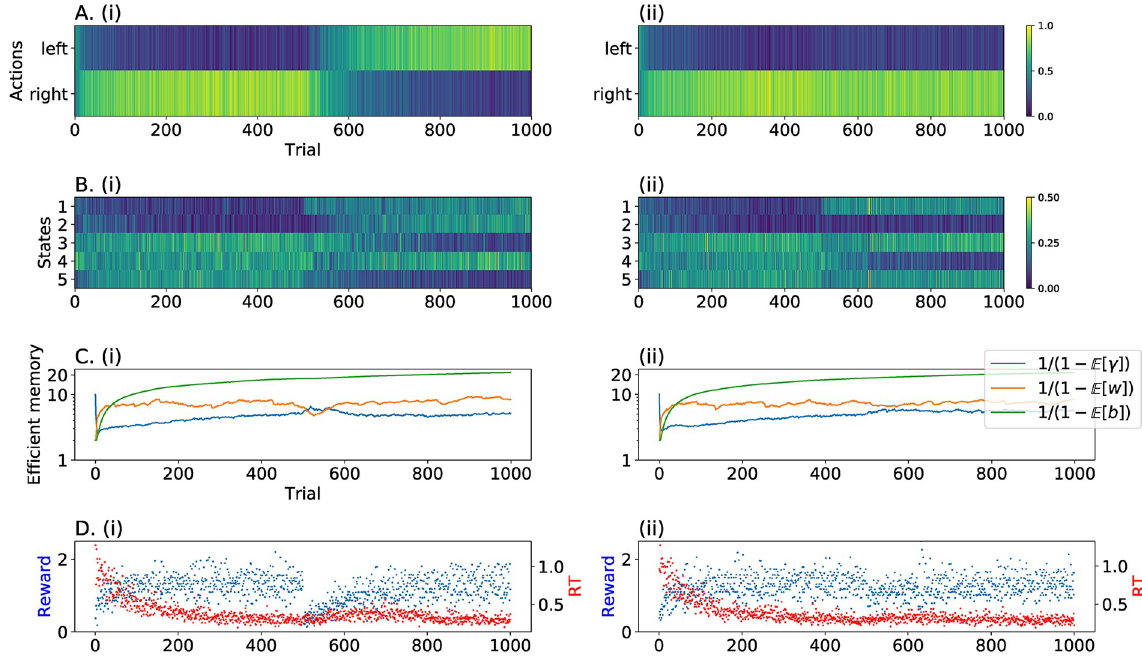
Fig 12. Behavioural results in the first (left of Fig 11) and second experiments (right of Fig 11). A . and B . Heat plot of the probability of visiting each state and selecting each action for the 64 agents simulated. (i) Agents progressively learned the first optimal actions (left action in state 3-4-5) during the first half of the experiment, then adapted their behaviour to the new contingency (right action in states 1-4-2). (ii) Similarly, in the second experiment, agents adapted their behaviour according to the new contingency (left action in 1-3-5). C . Efficient memory on the first and second level, and foreseeing capacity. Since the CC was less important in (ii) than in (i), because the left action in state 3 kept being rewarded, the expected value of w dropped less. The behaviour of the foreseeing capacity ( 1 ) and, therefore, of the expected value of γ , 1 (cid:0) E q ½ g � ½ g � tended to increase which had the is indicative of the effect that a CC had on this parameter: when the environment became less stable, E q effect of increasing the impact of future states on the current value. D . (i) Reward rate dropped after the CC, whereas the RT increased. The fact that subjects made slower choices after the CC can be viewed as a mark of the increased task complexity caused by the re-learning phase. Along the same line, RT decreased again when the subjects were confident about the structure of the environment. (ii) The CC had also a lower impact on the reward rate and RT in experiment